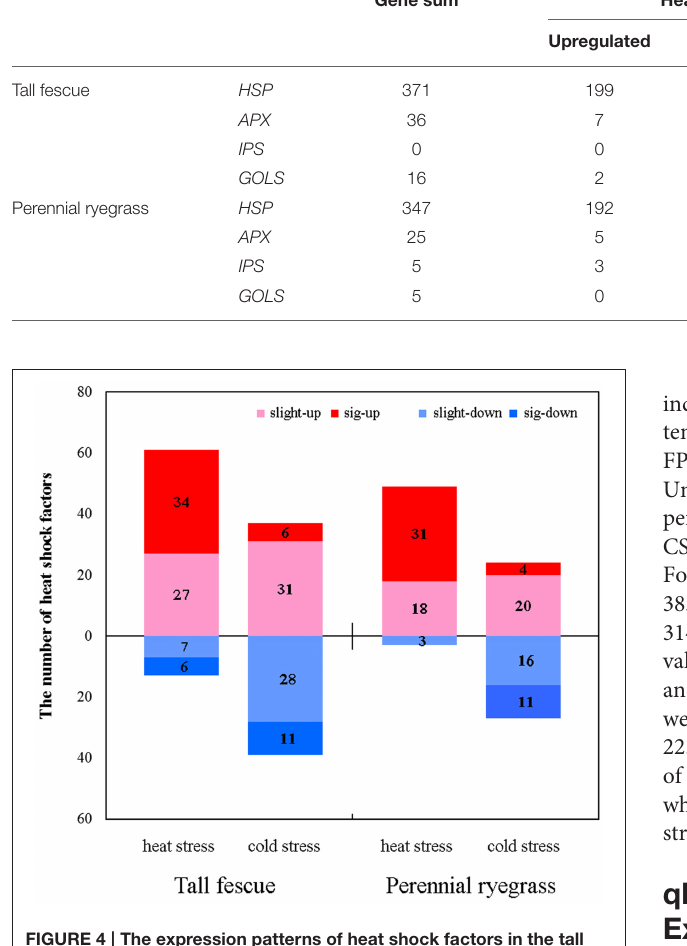
TABLE 1 | Genes encoding Heat shock proteins (HSPs), ascorbate peroxidases (APXs), inositol-3-phosphate synthases (IPSes), and four galactinol synthases (GOLSes) that show expression level changes responding to heat and cold stress in tall fescue and perennial ryegrass. Gene sum